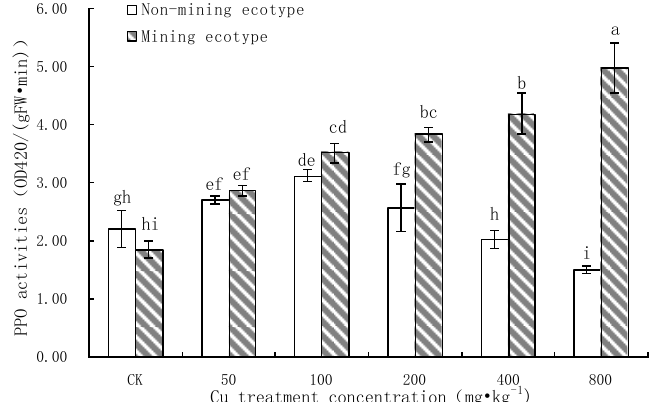
Figure 8. Activity of PPO of two ecotypes of M. floridulus under different Cu treatment. Note: Error bars indicate standard deviation; Different letters in the same group indicate significant difference at p < 0.05 according to Duncan’s multiple range tests; the same below.